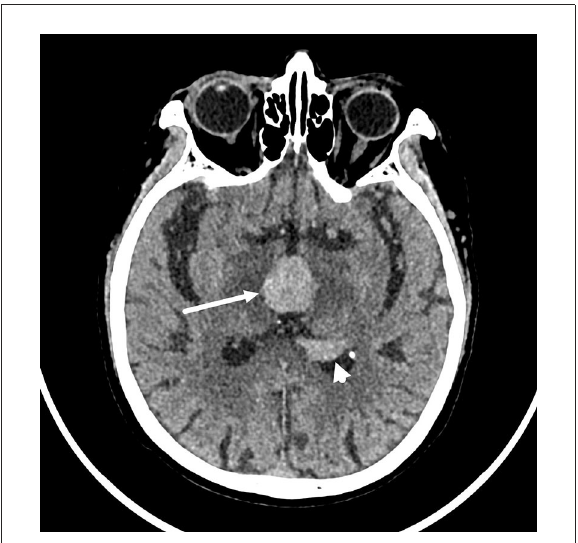
FIGURE1 Non-contrast computed tomography (CT) shows that the masses with slight hyper-attenuation were in the third ventricle (the tumor size: 22mm × 22mm × 15mm, CT value: 47HU) (arrow), in the body (not shown) and posterior horn (arrowhead) of the left lateral